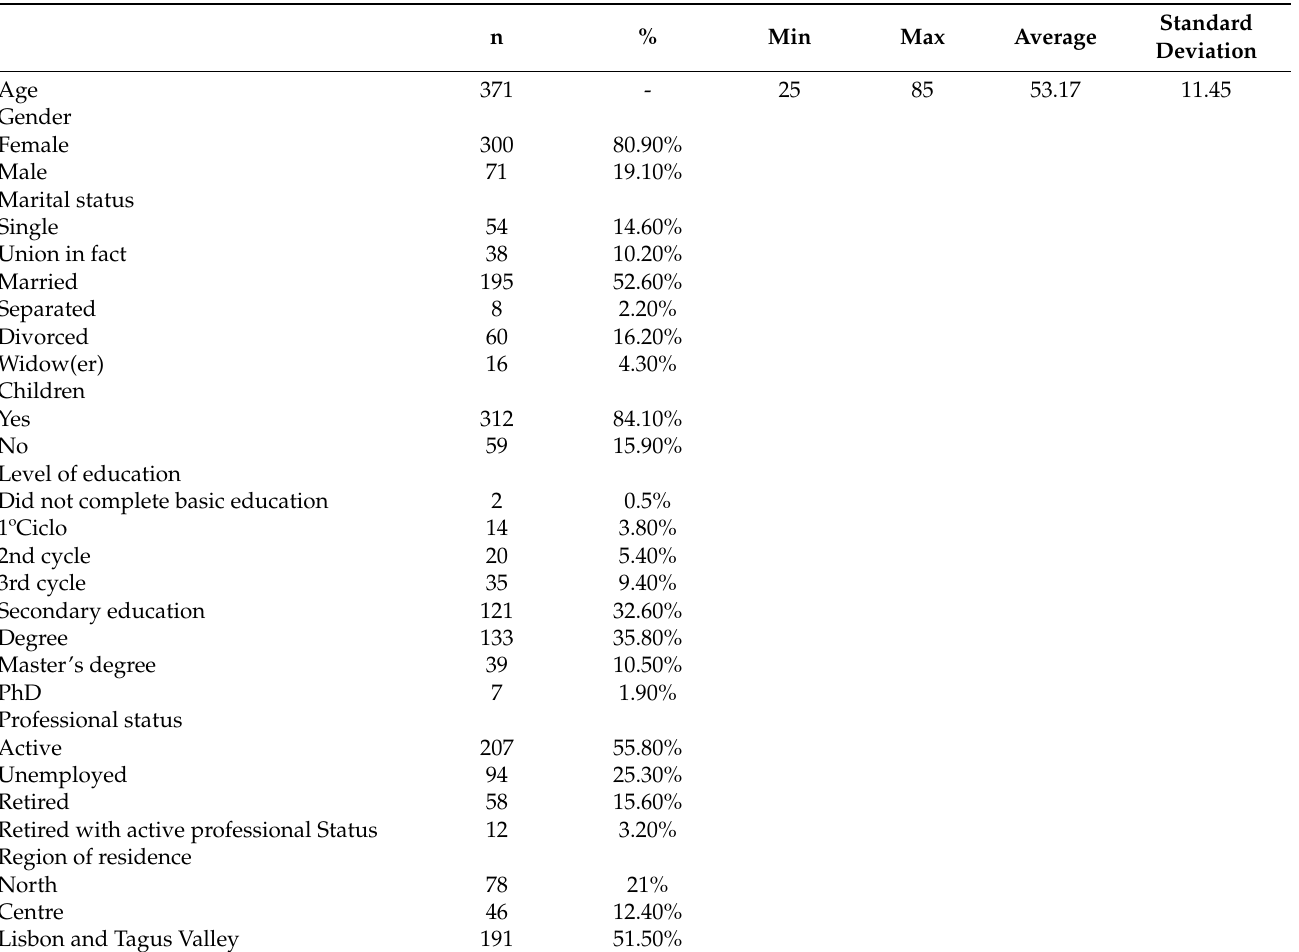
Table 1. Participants’ sociodemographic